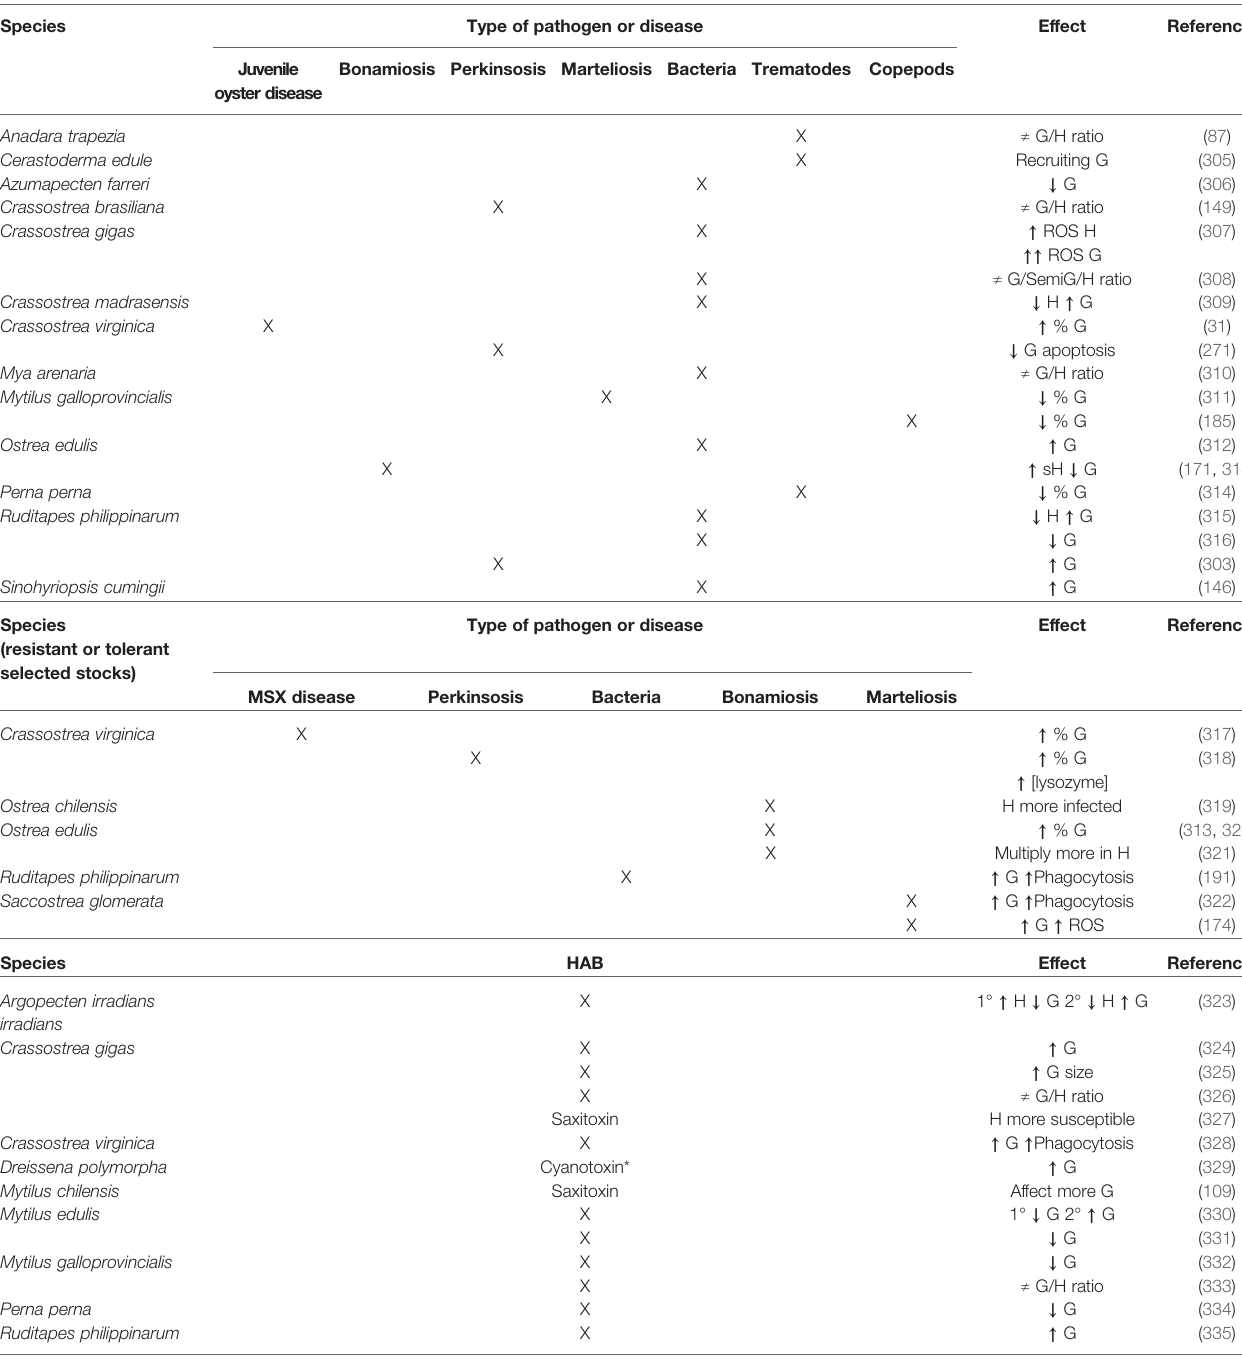
TABLE 2 | Literature survey of reported effects of biotic stress on bivalve haemocyte